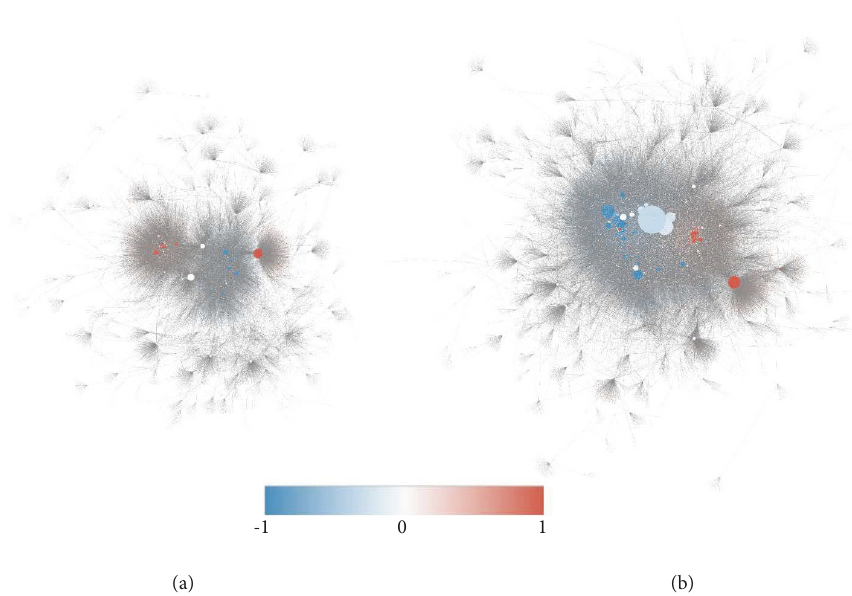
Figure 3: Retweets networks of the second round 2017 Chilean presidential elections corresponding to the electoral campaign period of 11-16 December (a) and 11-17 December (b). The size of nodes is proportional to their indegree k 𝑖𝑛 and the colors to their associated opinions, according to the scale shown below: -1 Guillier, 0 Neutral, and 1 Pi˜nera.